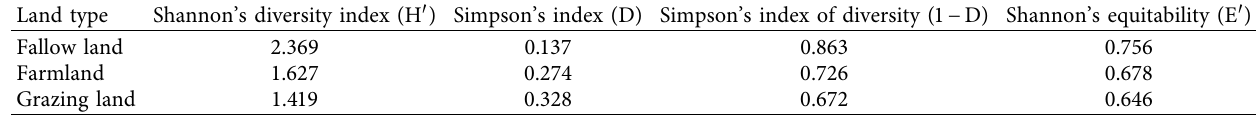
Table 4: Distribution of species in land types.